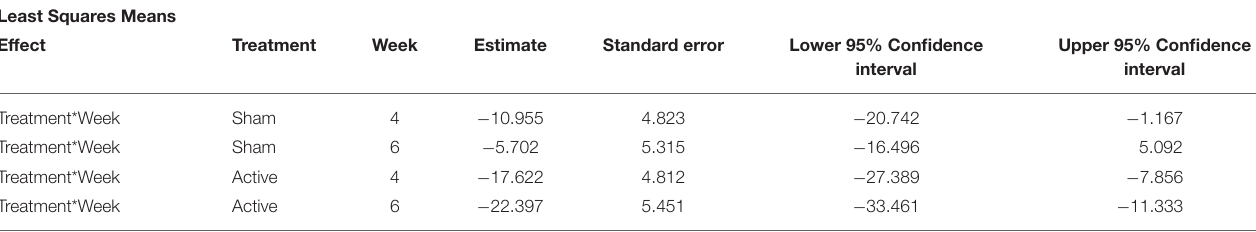
TABLE 4 | Expected mean difference and 95% confidence intervals for the comparison between week (4 or 6) and baseline for all negative behaviors recorded on the videos. Least Squares Means